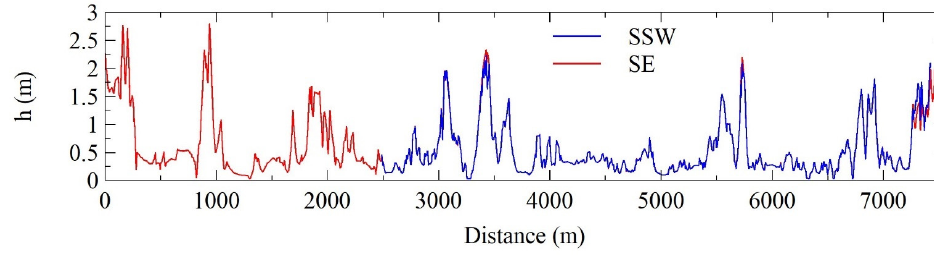
Figure 13. Modeled wave heights along the control line—incident directions: SE and SSW. Figure 13 . Modeled wave heights along the control line—incident directions: SE and SSW.